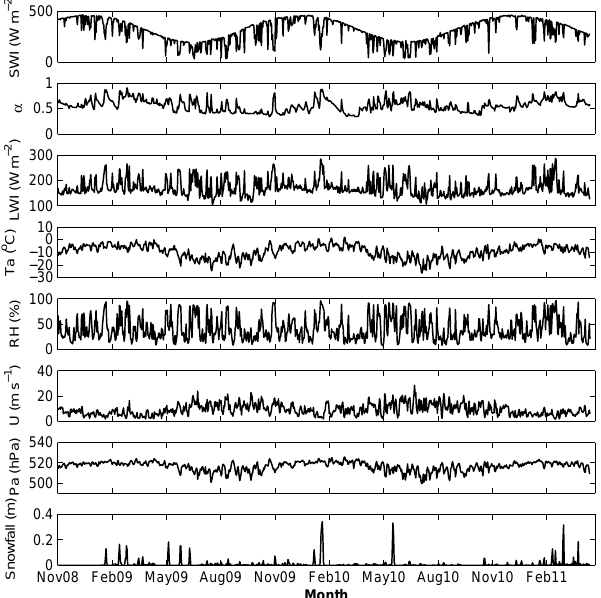
Fig. 2. Average daily incoming shortwave radiation (SWI), albedo ( α ), incoming longwave radiation (LWI), air temperature ( T a ), rela- tive humidity (RH), wind speed ( U ), air pressure (Pa) and snowfall measured at the Guanaco AWS from 1 November 2008 to 30 April 2011. al., 2002; MacDonell et al., 2013). Air temperature follows a seasonal pattern that is slightly delayed compared to the SWI cycle (Fig. 2). Higher temperatures are experienced dur- ing January and February than at the austral summer sol- stice, and lower temperatures are recorded in July and August than at the austral winter solstice. Mean temperature over the study period was − 9.3 ◦ C, and hourly temperatures varied between − 29.4 and 7.6 ◦ C. Average relative humidity is 40 % and relative humidity fluctuates greatly throughout the year (standard deviation 26 %), driven by cloud and precipitation events (Fig. 2; MacDonell et al., 2013). The wind speed aver- age ( ± standard deviation) is 9.2 ± 4.9 m s − 1 over the